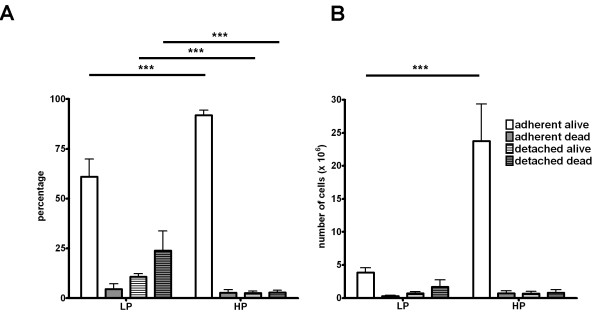
Viability of Ras-LP and Ras-HP cells in standard culture conditions. Adherent and non-adherent cells were harvested after 72 hours in culture, stained using tryphan-blue, and counted. A: Data presented as percentages of total amount of cells. ***: p < 0.001 (n = 5). Ras-LP cultures contain relatively more detached cells in the medium, of which the majority is dead. B: Data presented in (A) in absolute counts (n = 5). ***: p < 0.001 (n = 5). Ras-HP cell cultures contain relatively and absolutely more viable cells.